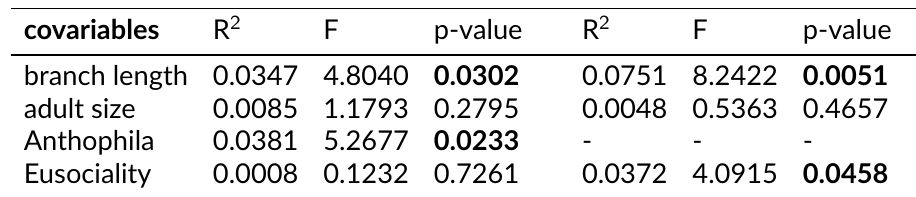
Table 1 – Linear modelling of corrected dN/dS ratios. Corrected dN/dS are obtained us- ing 3241 genes and GC-conservative substitutions. Displayed results are obtained when simultaneously using all covariables inside a multiple linear model. Phylogenetic indepen- dent contrasts are used for all variables so as to account for phylogenetic